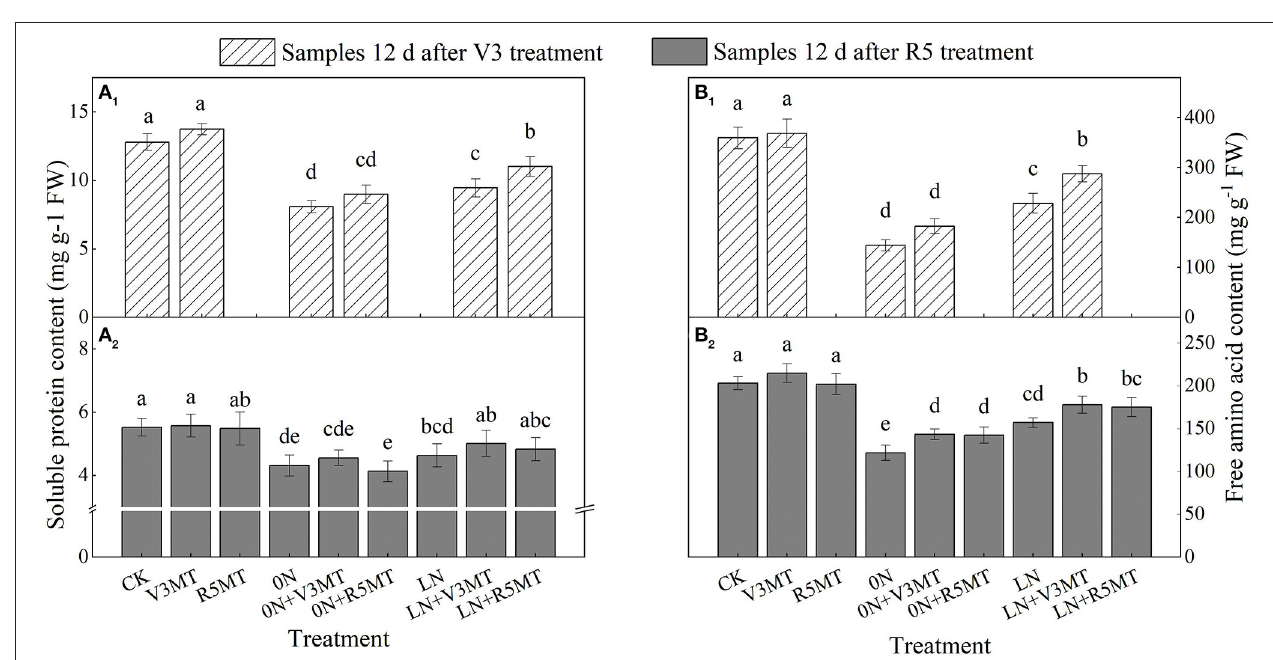
FIGURE 4 | The effect of exogenous melatonin (V3 and R5) on the content of nitrate (A) and ammonium (B) in plant leaves of under three N levels. The abbreviated meaning of each treatment is the same as in Figure 3 . The values were presented as mean ± SE ( n = 3). Different letters in one measuring group indicate statistically significant differences when P ≤ 0.05.